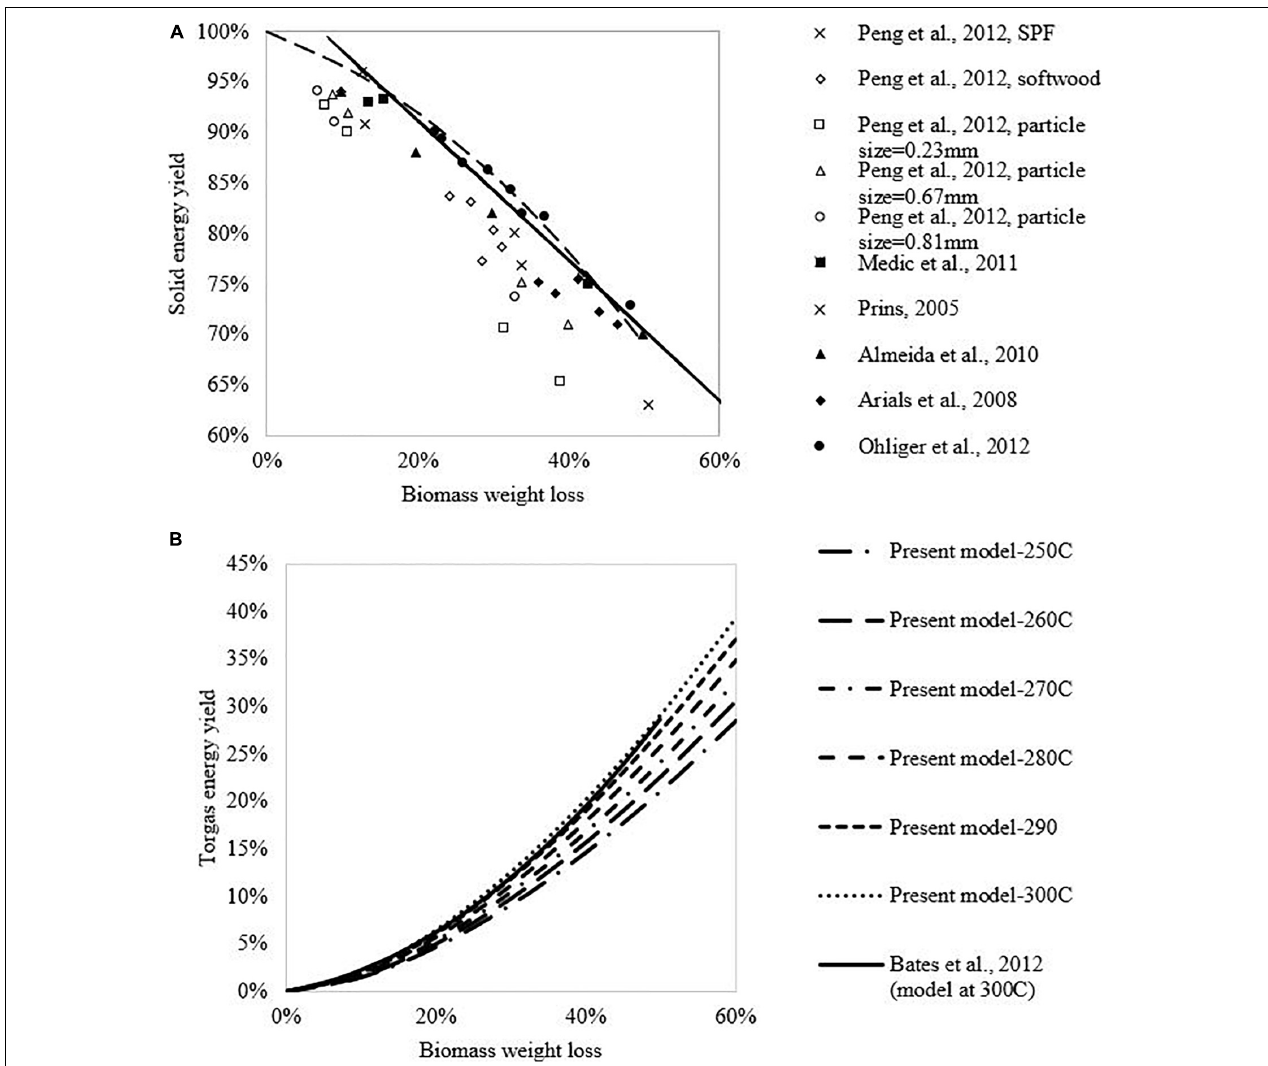
FIGURE 3 | Solid phase and volatile phase energy yields at different biomass weight loss and torrefaction temperature in comparison with the literature data. (A) Solid energy yield; (B) Torgas energy